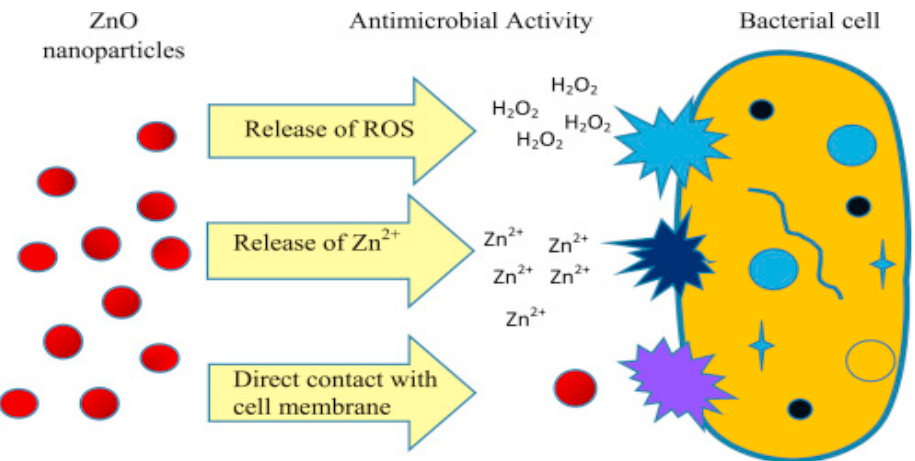
Figure 4. The mechanism of water disinfection by ZnO NPs [183].